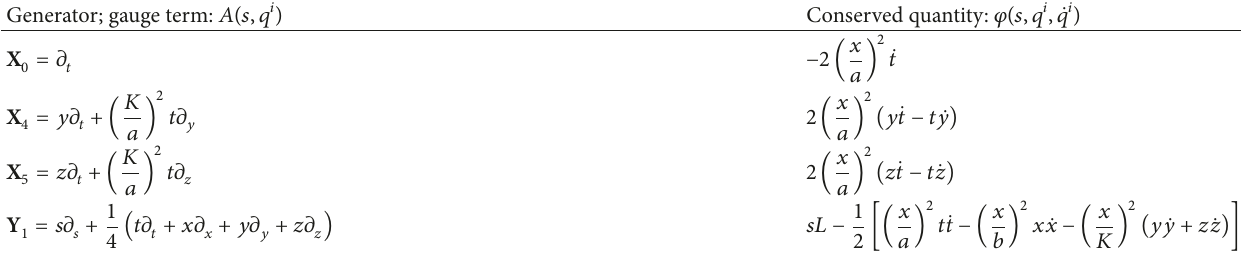
Table 24: Conserved quantities corresponding to each Noether symmetry.